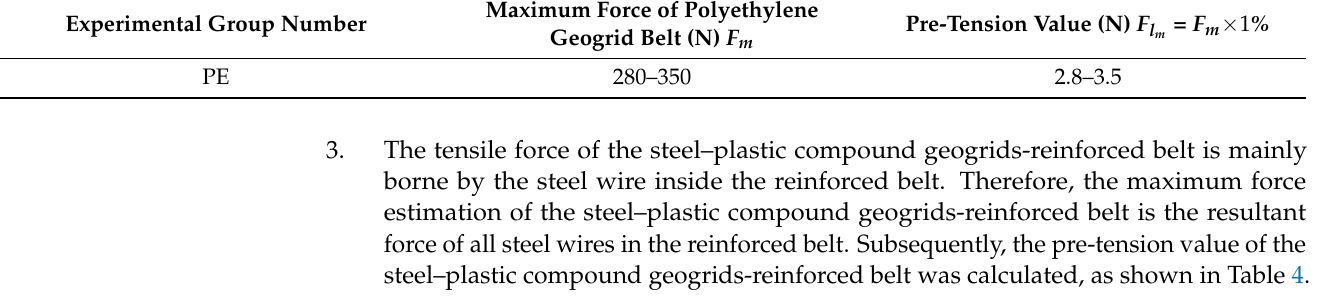
Table 4. Test pre-tension values of steel–plastic compound geogrid-reinforced